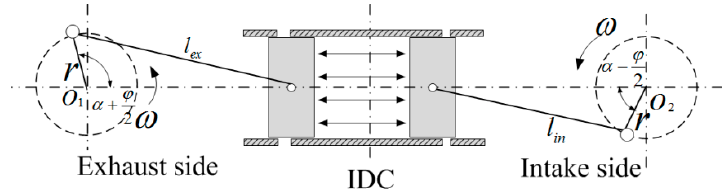
Figure 3. Opposed crank-connecting rod mechanism.